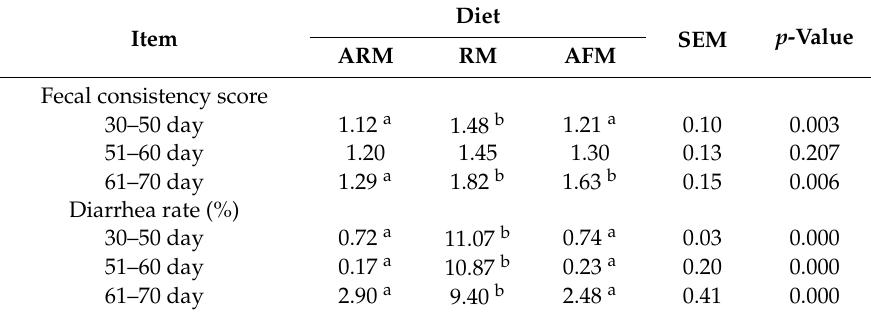
Table 6. Fecal score and diarrhea rate of dairy calves fed di ff erent types of milk. Item